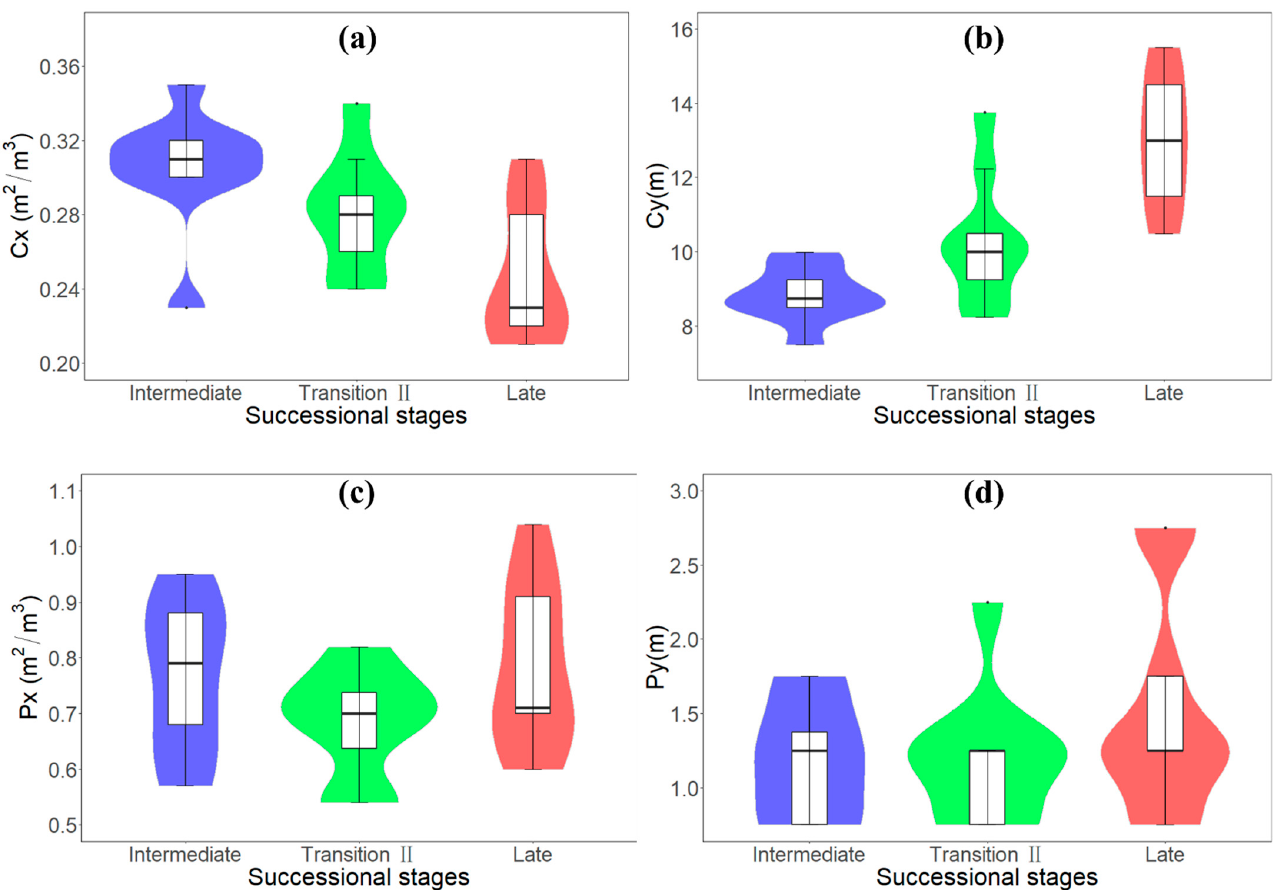
Figure 9. Violin plots for the LiDAR metrics (C x , C y , P x and P y ) distribution along the forest successional gradients (Intermediate–Transition II–Late) from 27 plots at the SRNP-EMSS, Guanacaste, Costa Rica. C x , the x coordinate of the waveform centroid; C y , the y coordinate of the waveform centroid; P x , the x coordinate of the maximum waveform amplitude; P y , the y coordinate of the maximum waveform